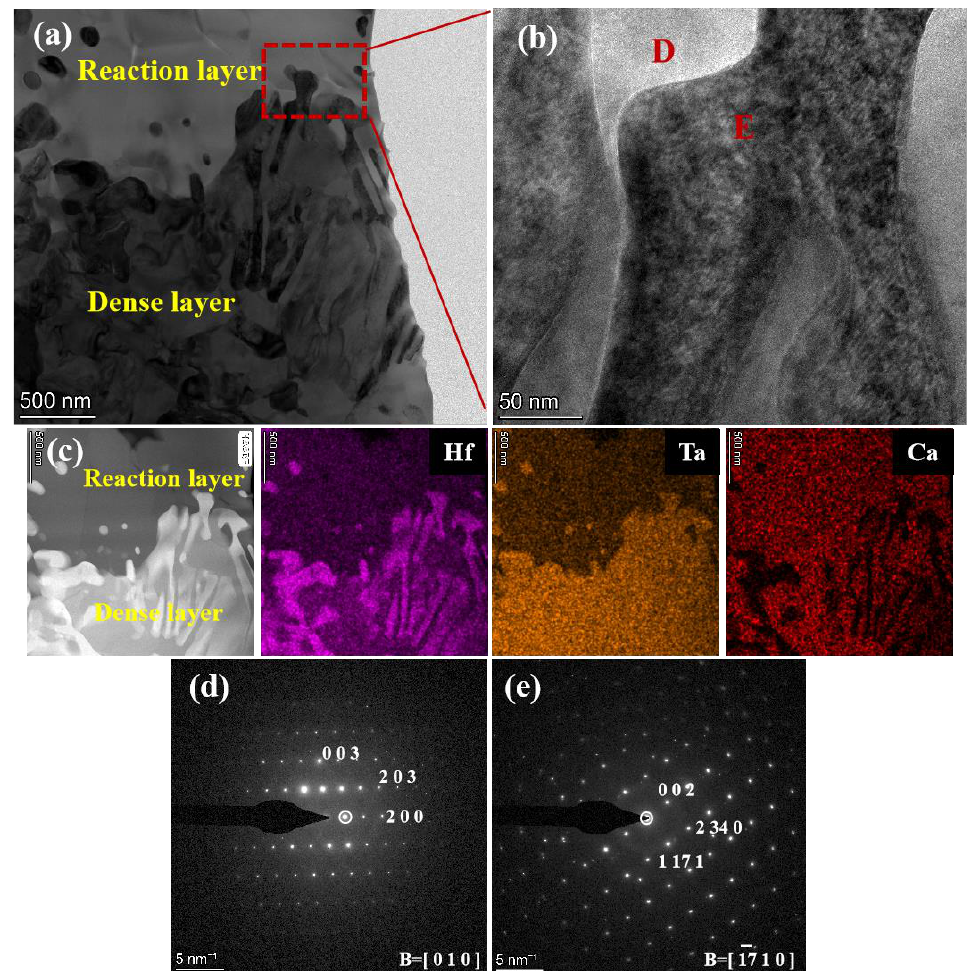
Figure 9. ( a ) Cross-sectional BF TEM image of CMAS reaction front corresponding to the dashed rectangle in Figure 8a; ( b ) magnified HAADF image of reaction interface indicated by in ( a ); ( c ) the corresponding EDS elemental mapping; ( d , e ) SAED patterns of D and E in ( b ).